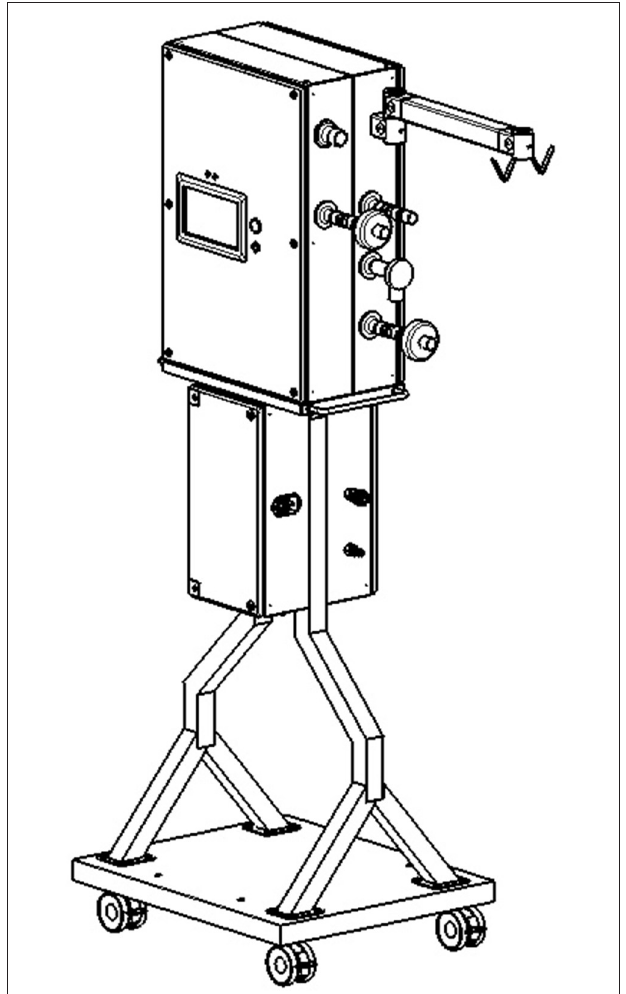
FIGURE 1 | Fully mature manufactured ATENA Ventilator